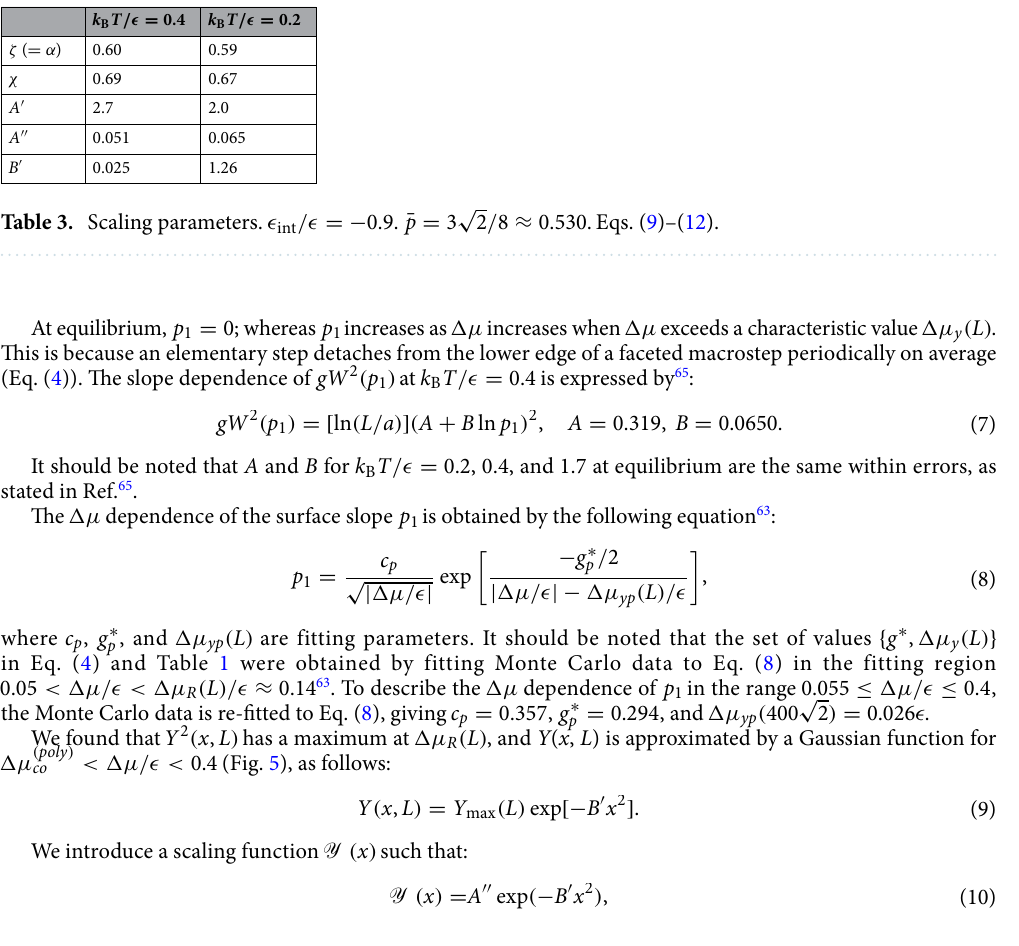
k B T /ǫ = 0.4 k B T /ǫ =